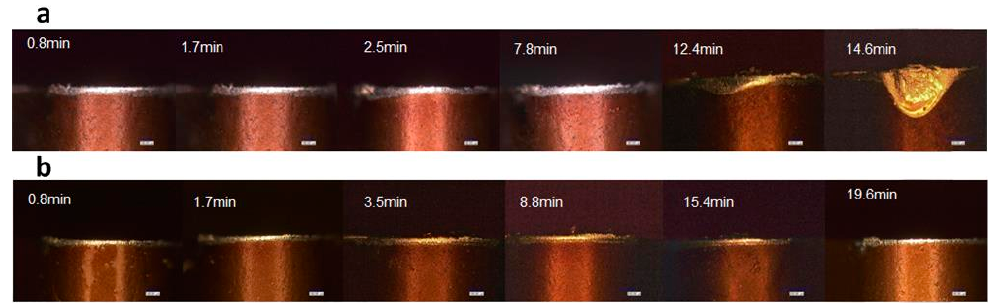
Figure 11. Optical images of tool wear and failure of Al 2 O 3 /TiAlN-coated insert (( a ) under dry cutting; ( b ) under MQL).